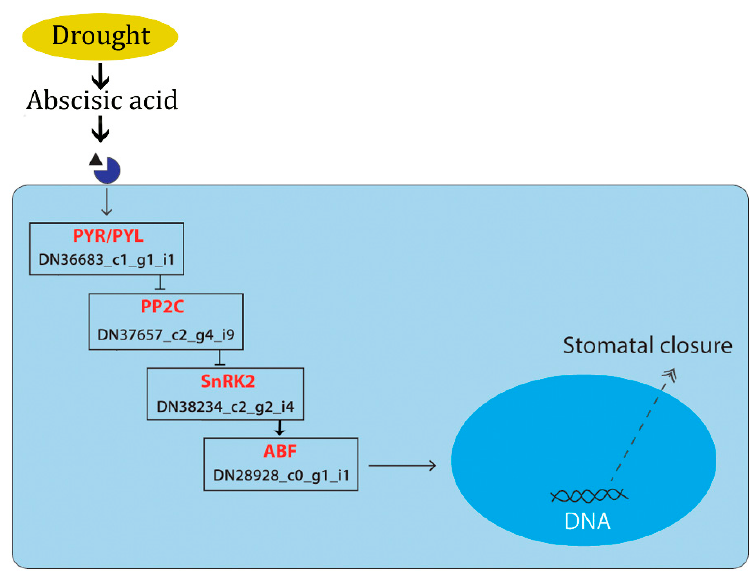
Figure 12. Schematic representation showing the transcript expressed under PEG-induced drought stress mapped in the ABA-mediated KEGG pathway. The genes expressed in the present study are given in red font and the transcript ID is given in black font.